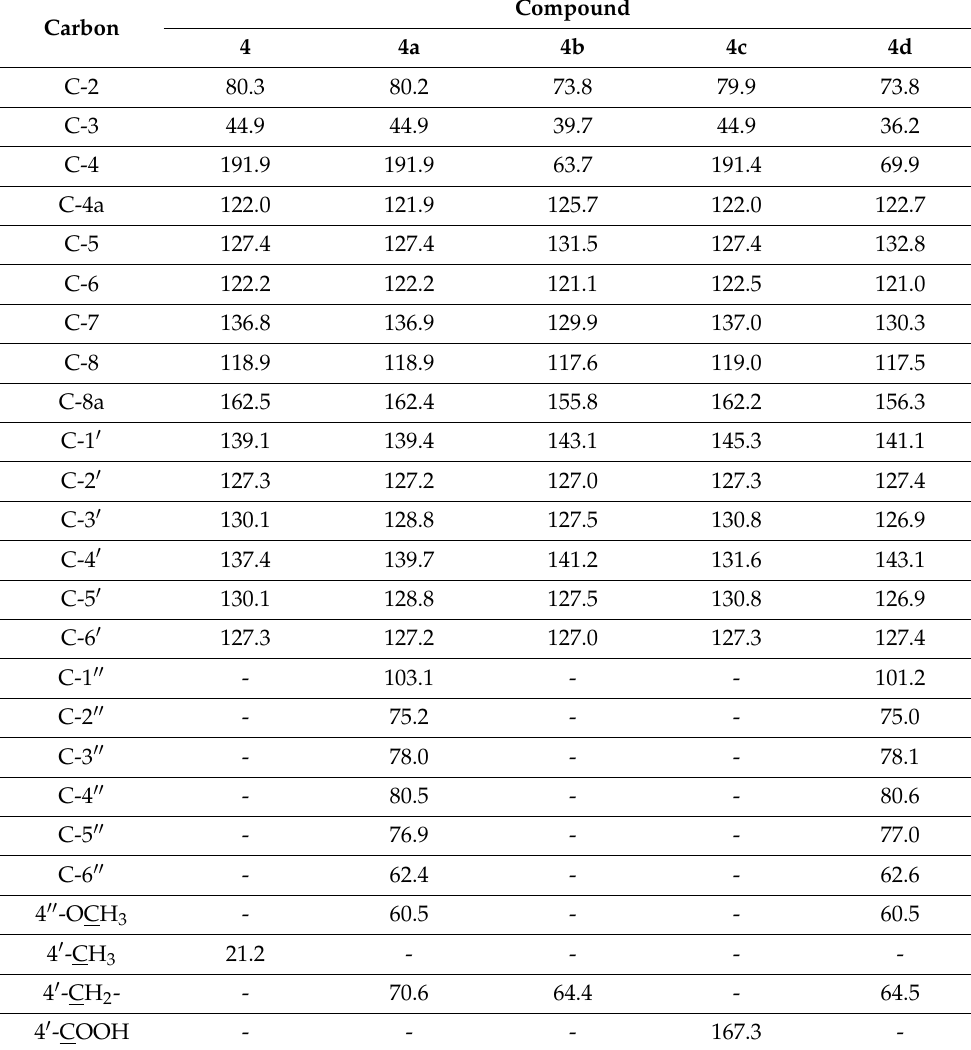
Table 2. 13 C-NMR chemical shifts δ (ppm) and coupling constants J (Hz) of 4 (cid:48) -methylflavanone ( 4 ) and products of its biotransformations, 4a – 4d, in acetone-d6, 151 MHz (Supplementary Materials: Figures S6, S7, S26–S28, S47, S48, S66, S67, and S87–S89).